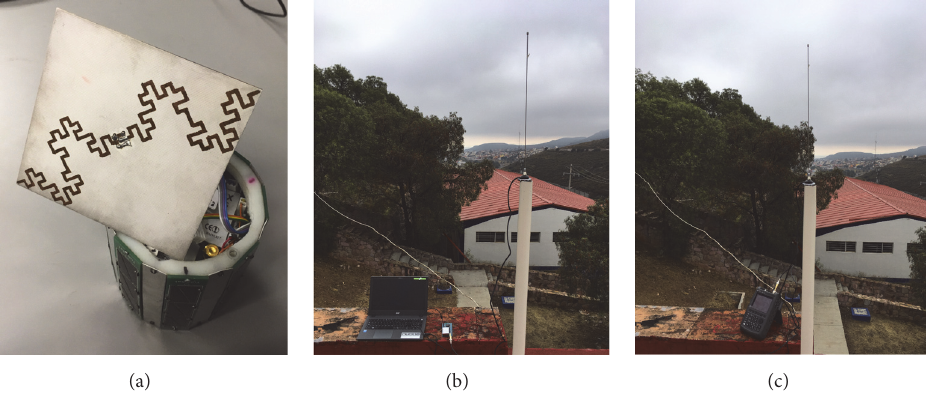
Figure 7: (a) The antenna design connected to the picosatellite, (b) the ground station with its UHF vertical monopole antenna getting telemetry data, and (c) the UHF vertical monopole antenna connected to the spectrum analyzer. < 1.2, and |𝑍 | ≈ 50 Ω . Radiation patterns at 436.5 𝐴